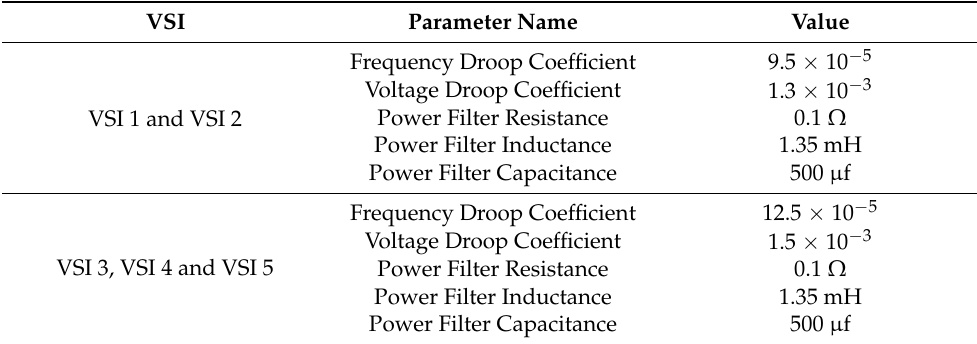
Table 2. The adopted droop coefficients and power filter parameters.